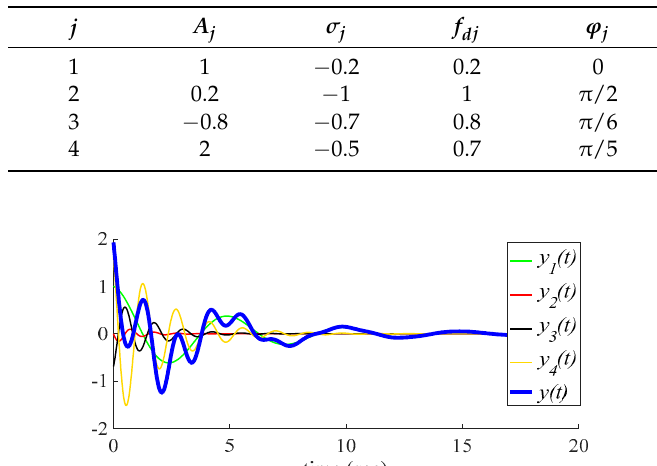
Table 1. Parameters of the Hypothetical Signal of Test Case 1.